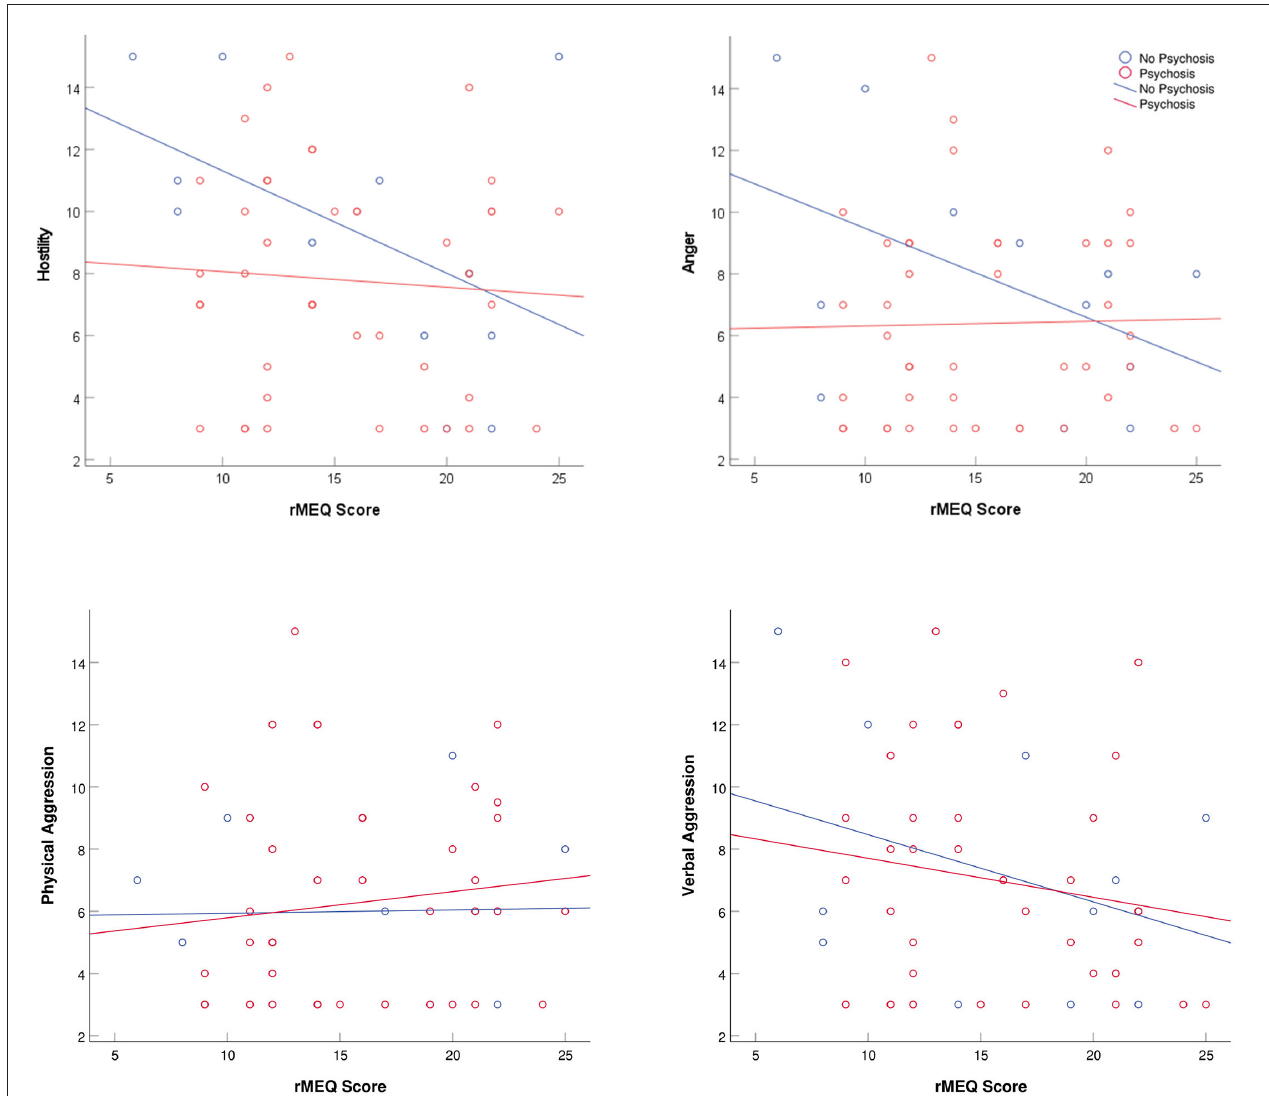
FIGURE 1 | Scatter plots of Buss Perry Aggression Questionnaire-Short Form (BPAQ-SF) subscores and reduced Morningness–Eveningness Questionnaire (rMEQ) scores separated by psychosis and non-psychosis populations. Low rMEQ scores indicate preference eveningness and high scores indicate preference for